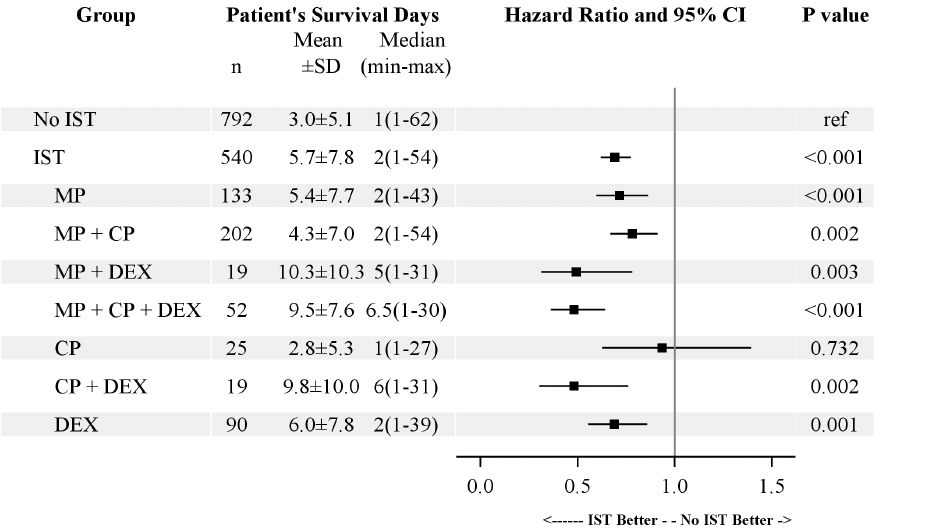
Figure 5. Comparison of survival day before mortality in paraquat-poisoned patients with additional different combined immunosuppressive regimens and hemoperfusion. Cox regression analysis of mortality rates among different treatment groups, adjusted for age and sex, was used to calculate the hazard ratio. All patients received hemoperfusion. Abbreviations: No IST: No immunosuppressive treatment (Hemoperfusion alone); IST: Immunosuppressive treatment; MP: Methylprednisolone; CP: Cyclophosphamide; DEX: Dexamethasone.